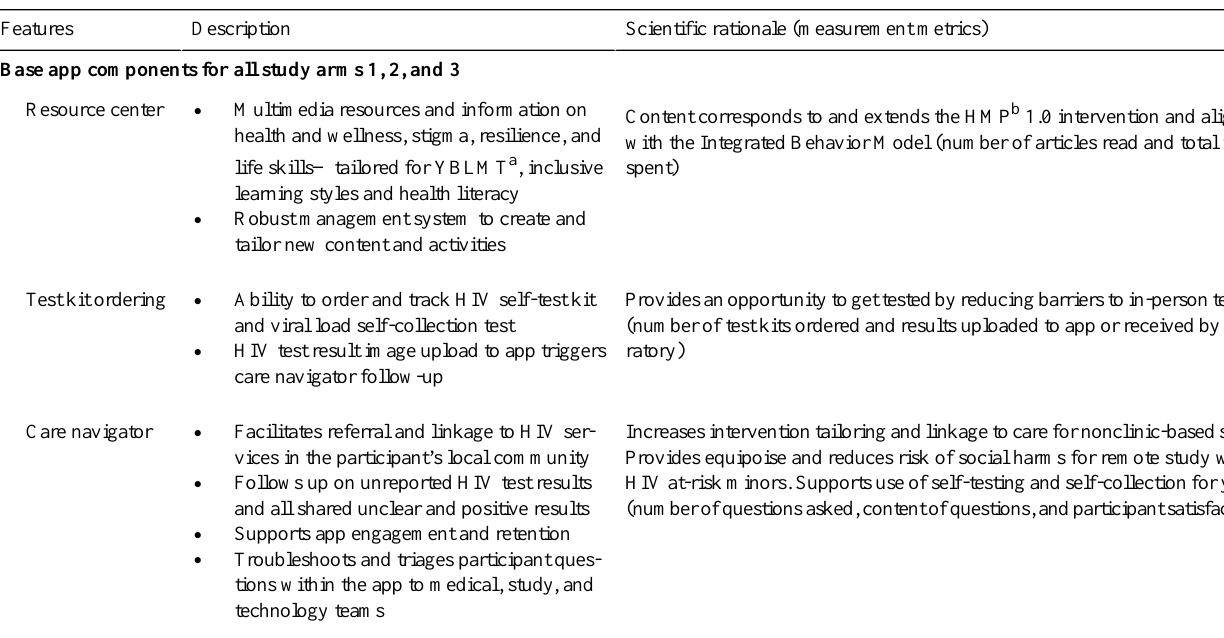
Scientific rationale (measurement metrics)DescriptionFeatures